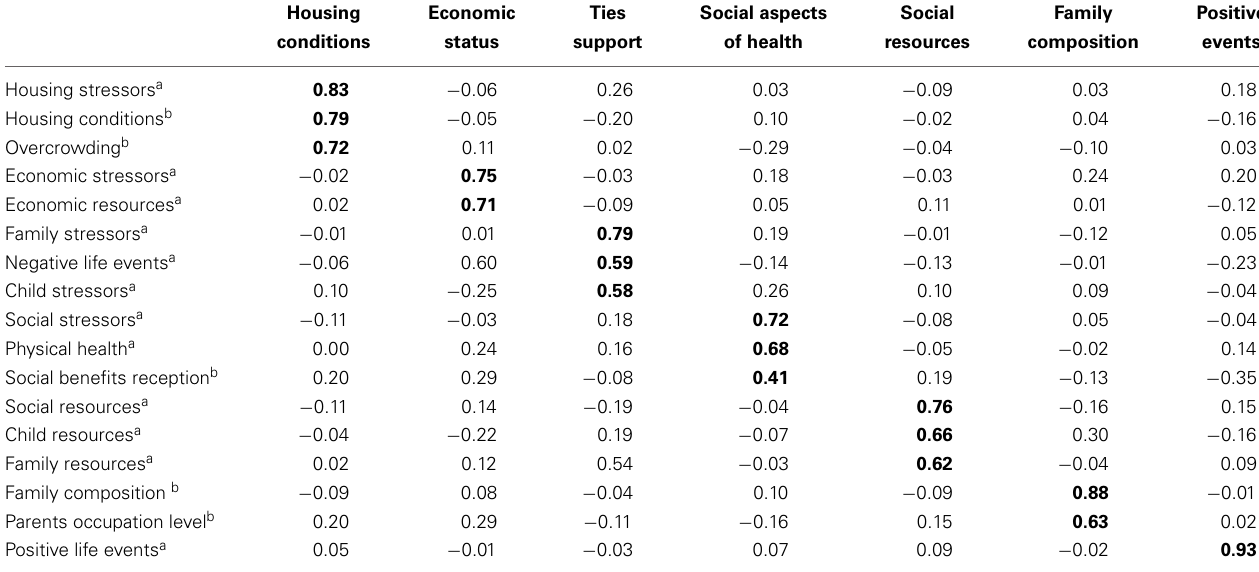
Table 12 | PCA results depicting variables associated with socioeconomic status and level of stressors and resources in the